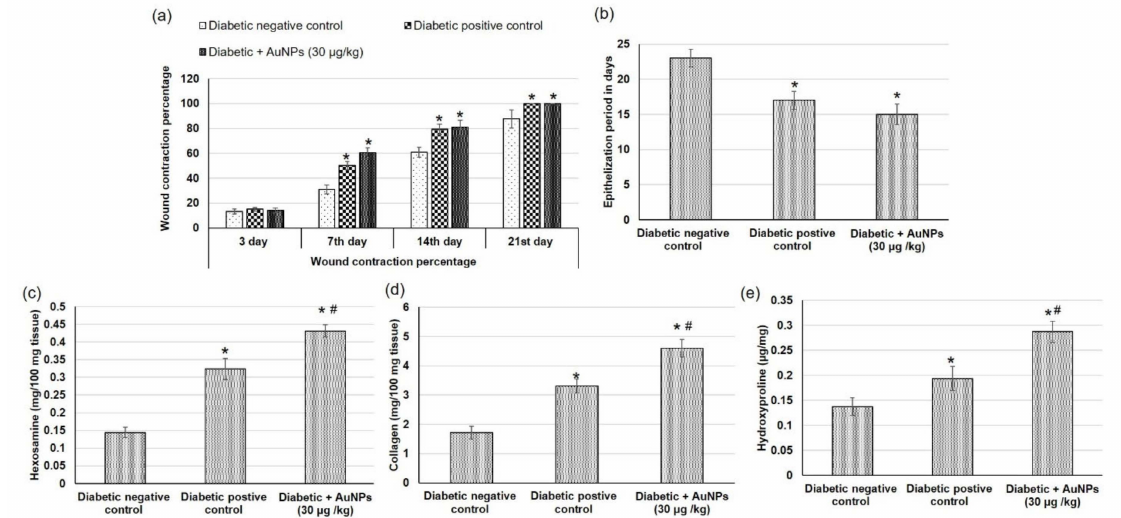
Figure 8. Effect of topical application of Au-NPs in excision wound model on wound healing parameters including ( a ) wound contraction percentage obtained from different experimental groups at 0, 3, 7, 14, and 21 days of post wounding ( b ) epithelialization period, ( c ) hexosamine, ( d ) collagen and ( e ) hydroxyproline contents in diabetic animals. All values were expressed as mean ± SD ( n = 6). * indicates statistically significant from the diabetic negative control group ( p < 0.05), # indicates statistically significant from diabetic positive control group using one-way ANOVA followed by Tukey’s test as a post hoc